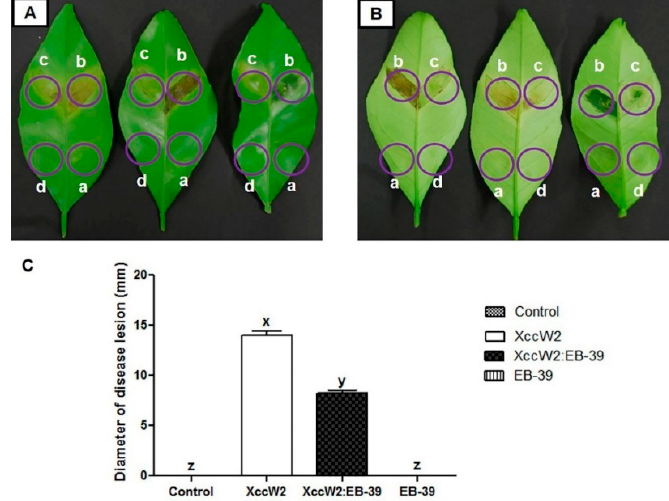
Figure 5. Testing the pathogenicity and disease suppression ability of EB-39 against X. citri subsp. citri ( Xcc W2) on citrus leaves. ( A ) adaxial surface and ( B ) abaxial surface of the same leaves. In all cases,